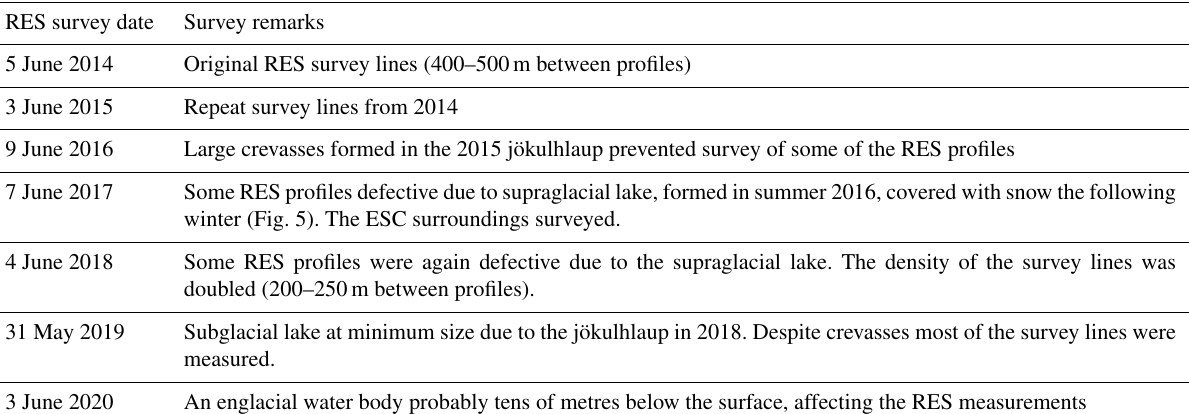
Table 1. Dates and specific remarks on individual RES